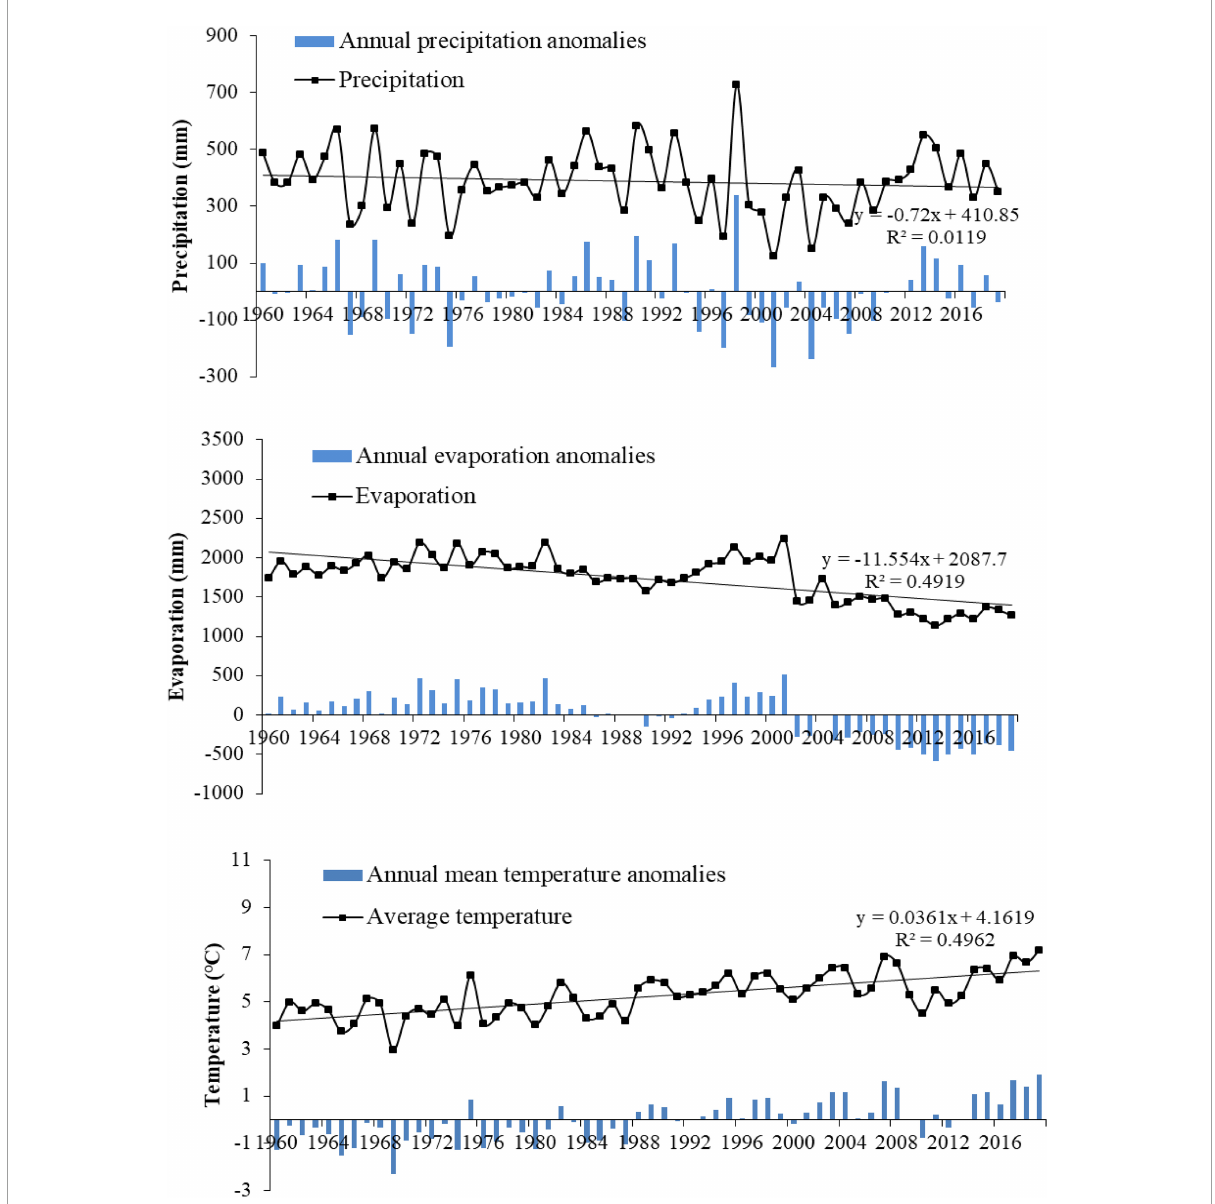
FIGURE8 Variation of precipitation, evaporation, and temperature in the study area from 1960 to